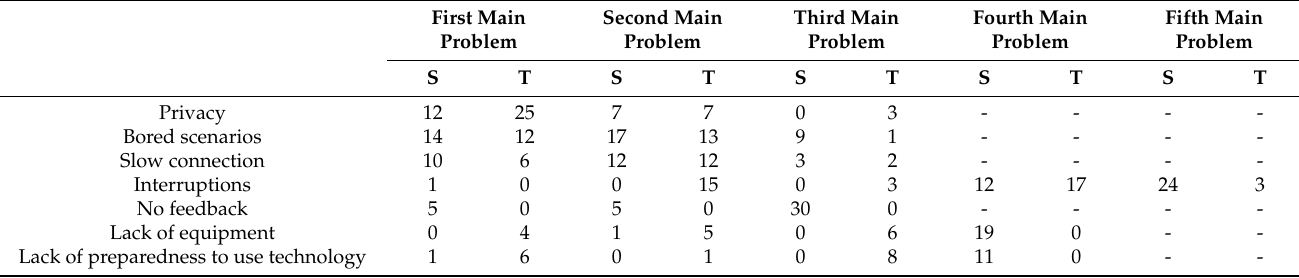
Table 9. Frequency of each problem by choice order and by role